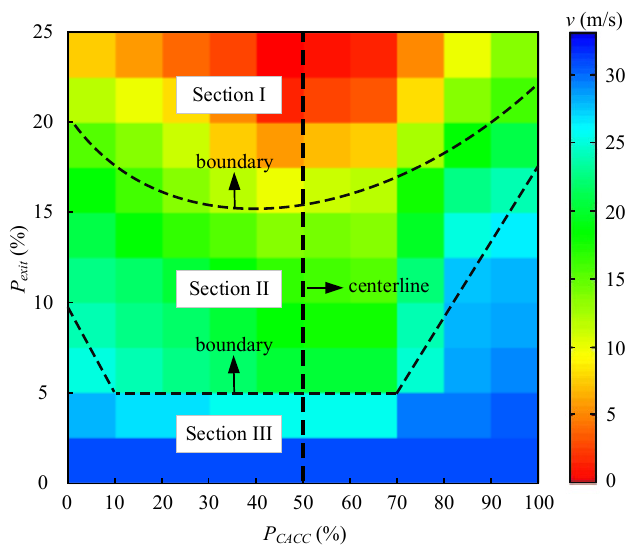
Figure 10. Summary of average speed in different traffic scenarios.